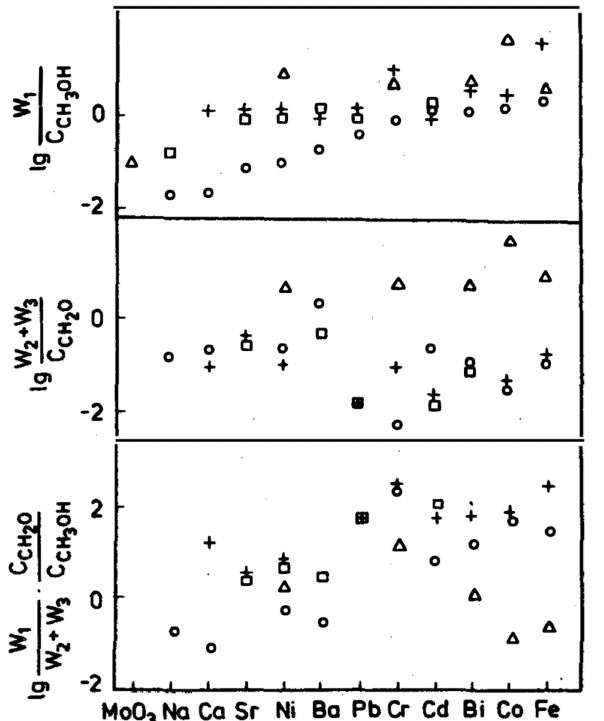
(cid:16) (cid:17) ln W 1 , activity to CO x C CH3OH normal molybdates; (cid:3) (cid:35)